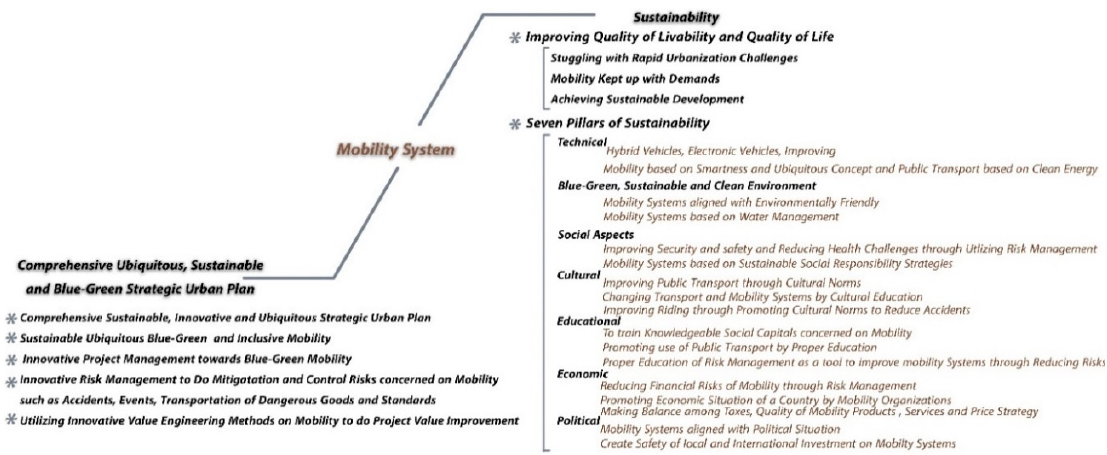
Figure 11. Comprehensive Sustainable Mobility Theory.